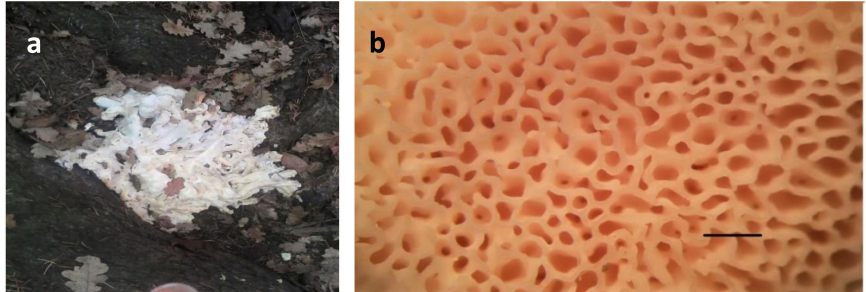
Figure 1. The albino maitake specimen: ( a ) Basidioma in situ; ( b ) Pore surface under the stereomicroscope (scale bar = 1